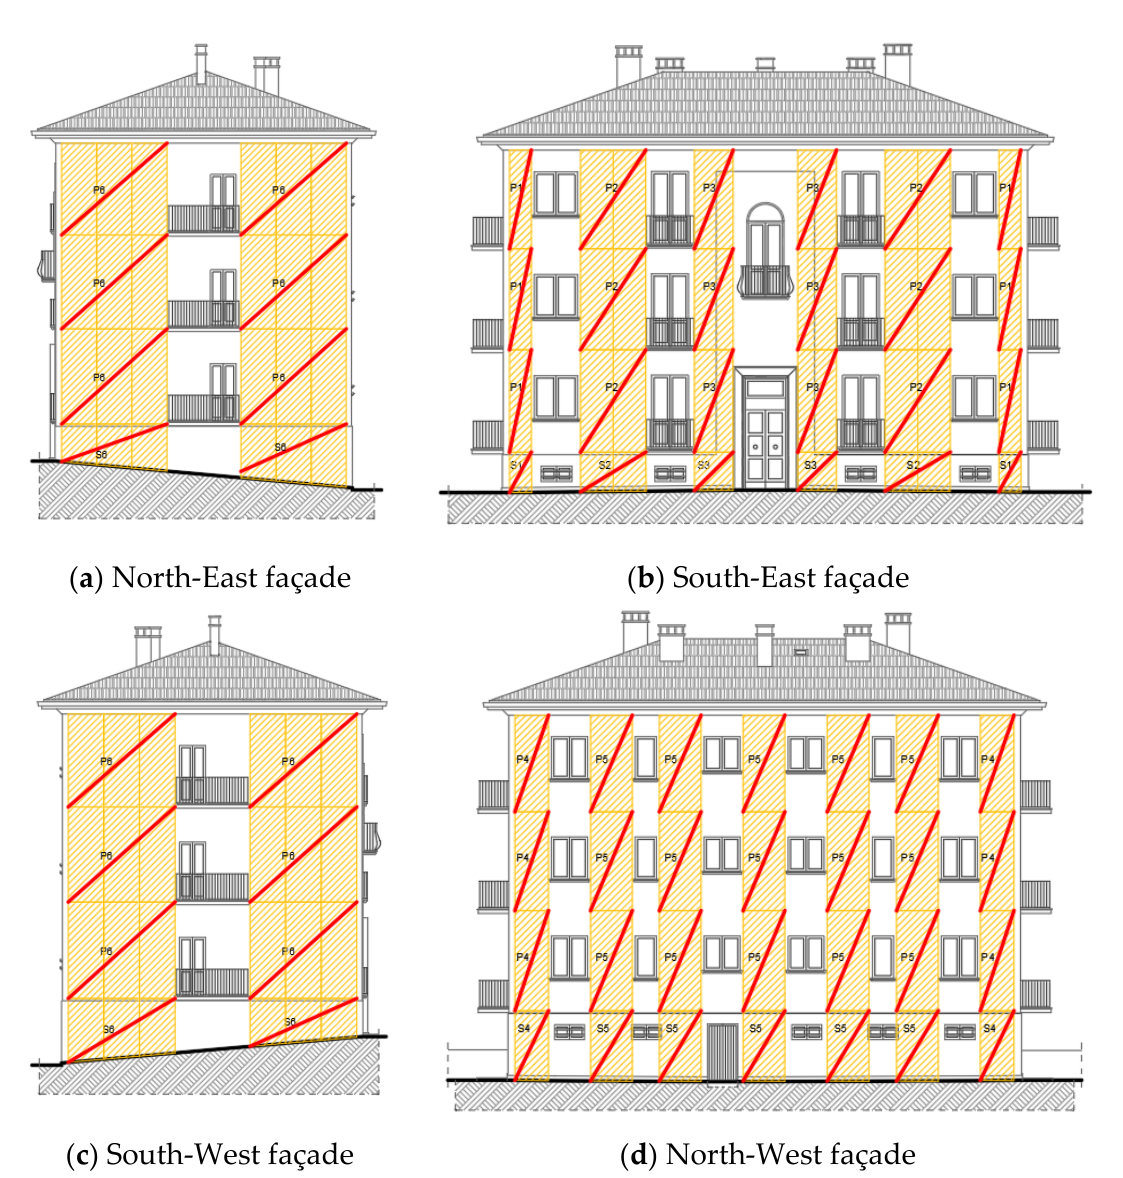
Figure 15. Identification of masonry panels and corresponding equivalent diagonals on the building facades (North-East ( a ), South-East ( b ), South-West ( c ) and North-West ( d )). The Resisto 5.9 coat was applied continuously on the entire façades with a variable distance between the uprights and crosspieces, which was assumed in any case not to exceed 1060 mm. The placement of envelope profiles on the facades is shown in Figure 16, which highlights the system continuity necessary not only for a better seismic response, but also for the installation of the insulation panels needed to reduce the thermal dispersion and to avoid thermal